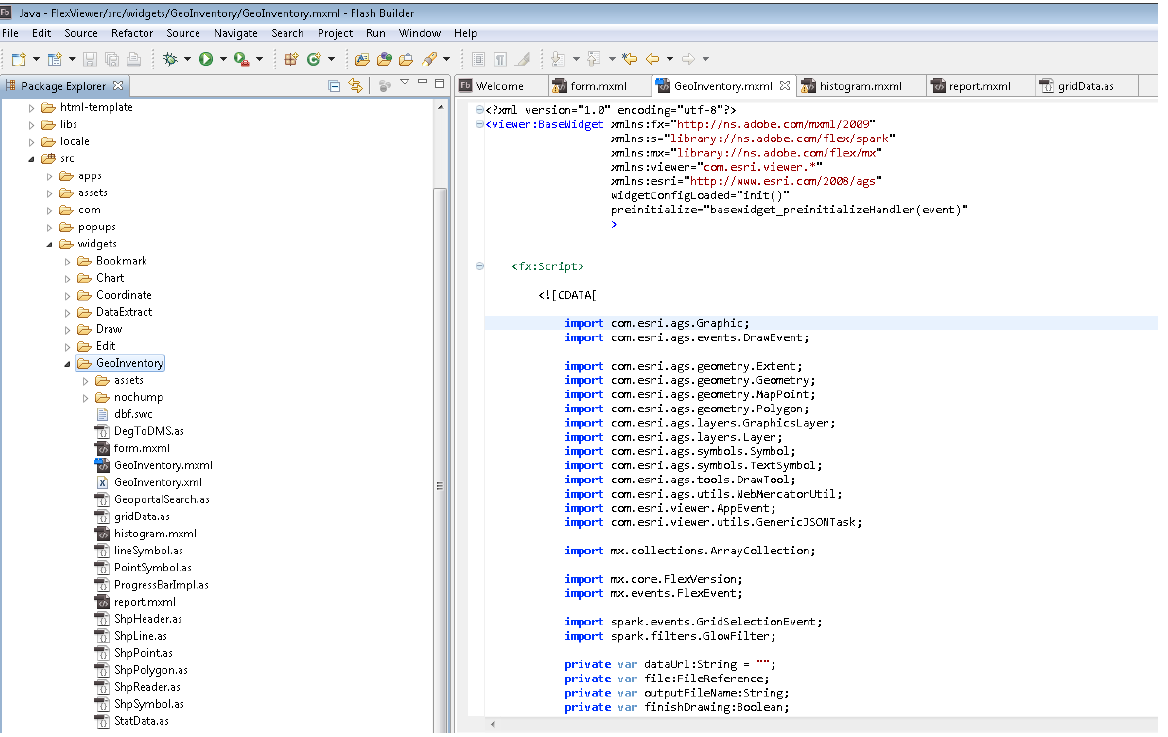
Figure 4. Programming code customization to support the GeoInventory